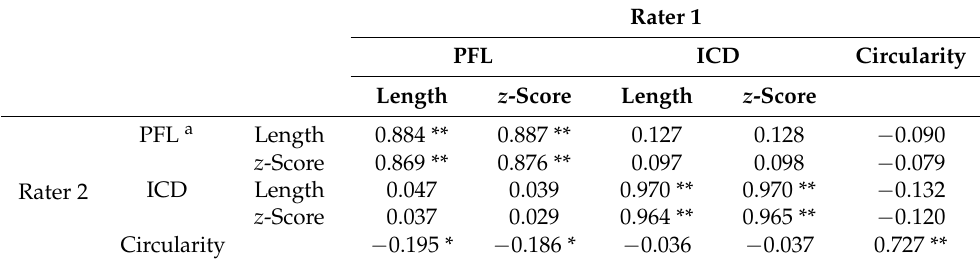
Table 2. FAS software score correlations (Pearson’s r) between two independent raters, n = 129. Rater 1 PFL ICD